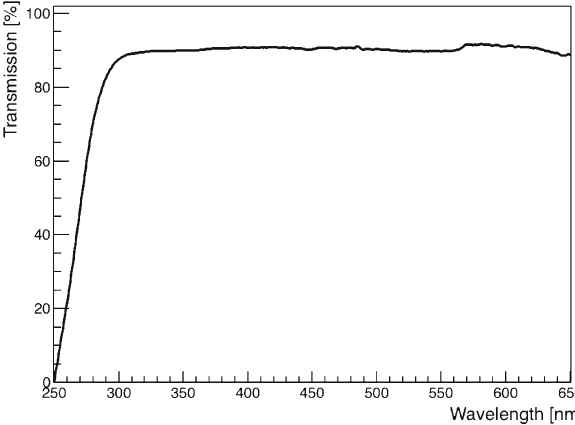
Fig. 8 Transmission as a function of wavelength for 2.54-cm diameter and 0.32-cm thick SUVT acrylic disk. This was measured using the spectrometer and the